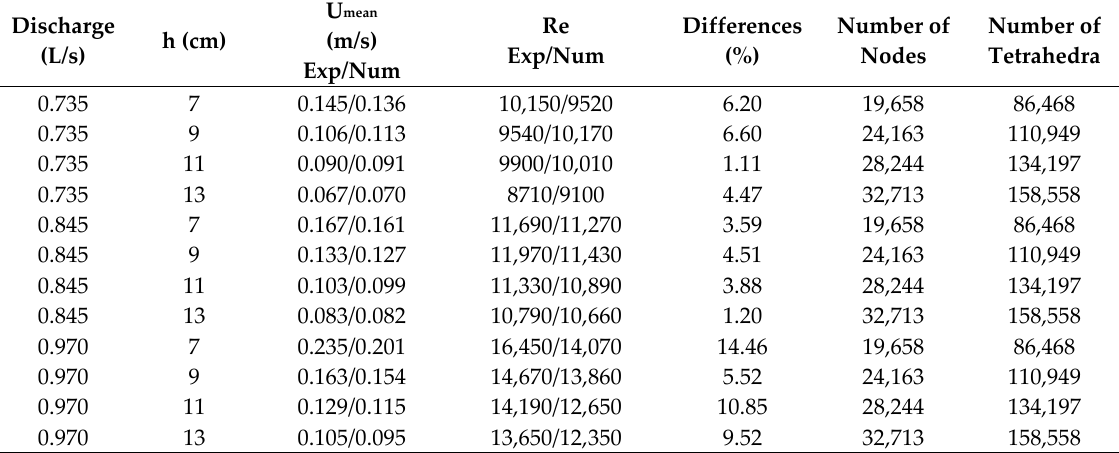
Table 1. Mesh parameters and comparison between experimental and numerical